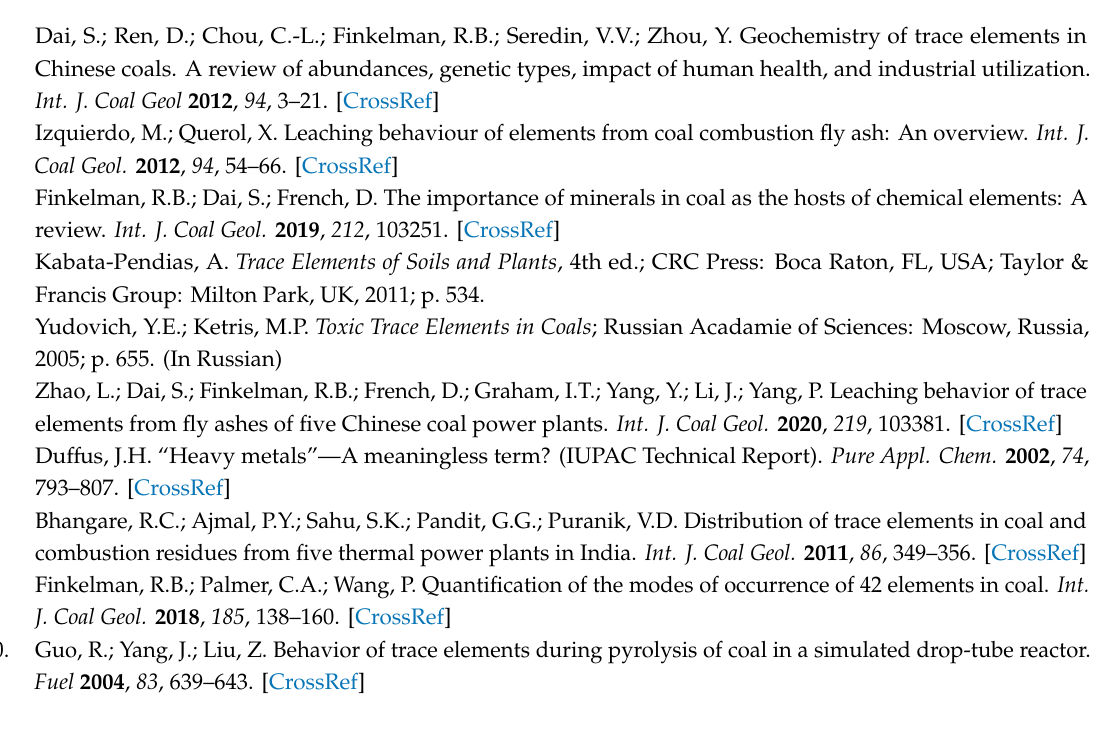
Table S1: Sampling locations; Table S2: Results of reflected microscopic analysis; Table S3: X-ray di ff ractometric analysis results; Table S4: Separation e ffi ciency for fly ash and slag; Table S5: Content of elements in coal ash samples; Table S6: Content of elements in samples feed coal; Table S7: SEM analysis results; Table S8: Results used to calculate the Pearson correlation coe ffi cient; Table S9: Pearson correlation coe ffi cient values; Table S10: Content of elements in samples fly ash and slag; Table S11: Arithmetic average of the elements content in feed coal; Table S12: Enrichment factor calculations; Table S13: Summary of the results of elements occurrence in coal and elemental distribution in fly ash and slag, and their contribution to determining the average content of elements in combustion